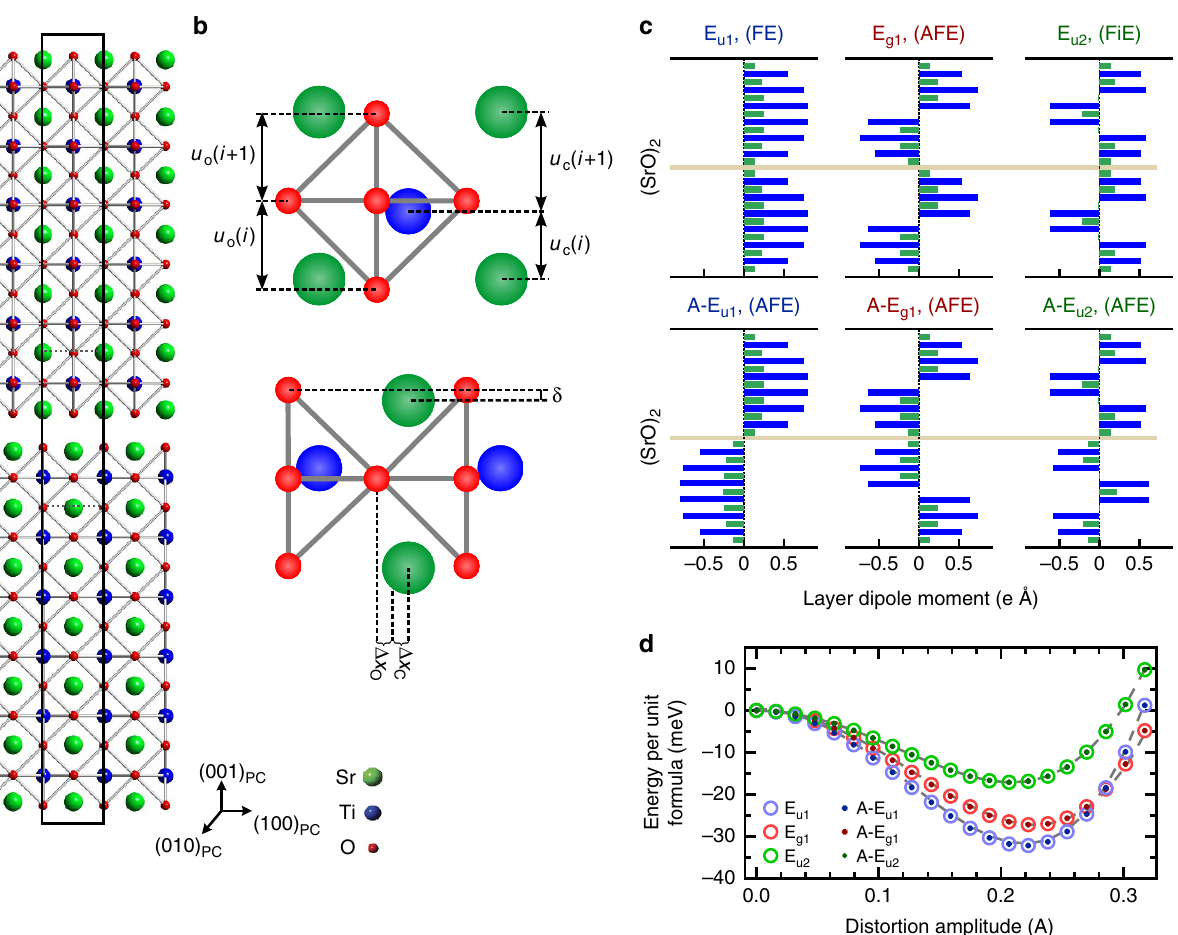
Figure 1 | Atomic structure and diversity of FE phases of Sr 7 Ti 6 O 19 . ( a ) DFT-calculated paraelectric unit cell structure, black outline, of Sr 7 Ti 6 O 19 with the rock salt layer (SrO) 2 in the middle. ( b ) Enlarged view of the rock salt region showing the correlated rumpling d and the cation and oxygen interplanar distances, u C and u O , respectively due to the presence of the rock salt layer. The polar displacements of the cations D x C and oxygen D x O atoms away from their paraelectric state positions are shown. All distortions are exaggerated for clarity. ( c ) DFT-calculated layer dipole moment for the SrO (blue bars) and TiO 2 (green bars) layers along the [100] PC axis for the predicted FE, FiE and AFE unit cells. The unit cell net polarization for each nanoslab lies along one of the h 110 i PC directions. The three metastable phases, E u1 , E g1 , and E u2 , arise from the unstable G -point phonons, and the A-E u1 , A-E g1 , and A-E u2 phases, are obtained by zone boundary ( k z ¼ p / c ) phonons. ( d ) Calculated energy as a function of displacement (mode amplitude) for the various phonons. Note that the G -point modes are degenerate to those of the corresponding zone boundary